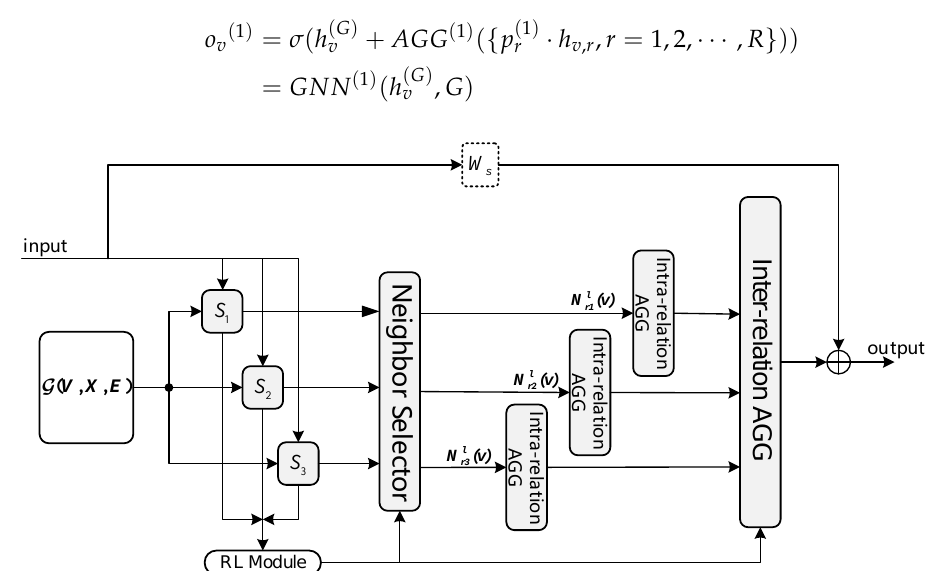
Figure 9. Details of a layer of RLC-GNN. W s is a trainable weight matrix to match the embedding’s dimensions between the input nodes and output nodes of the current layer. S i denotes the similarity measure module for the i -th